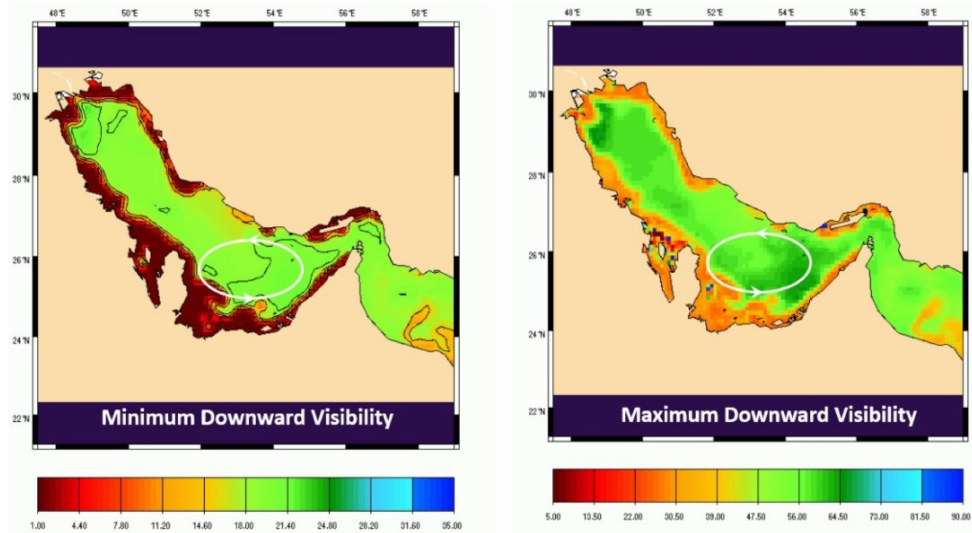
Figure 29. Persian Gulf min and max downward visibility (source: SHOM’s Mars